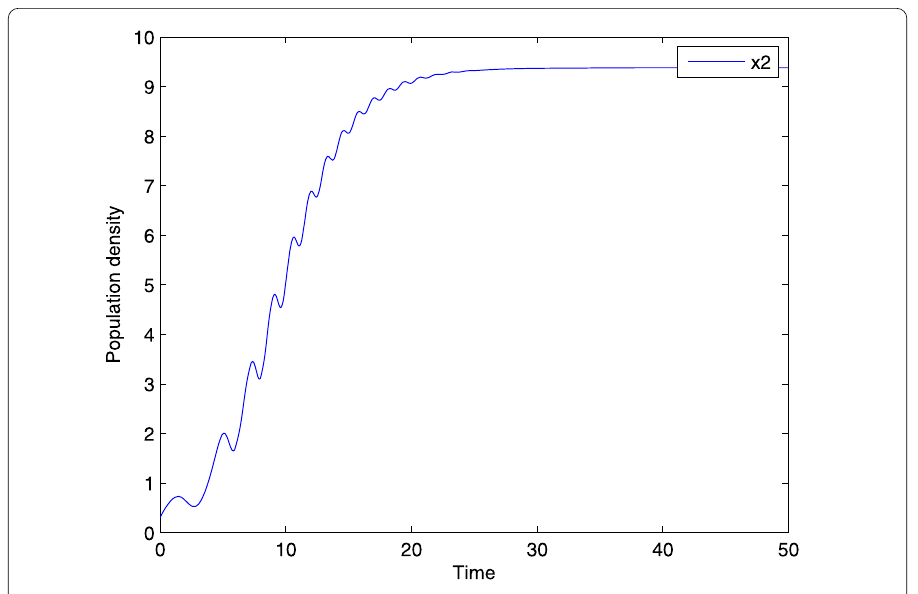
Figure 8 Changing of the adult prey x 2 with variable structure control. Changing of the adult prey x 2 with variable structure